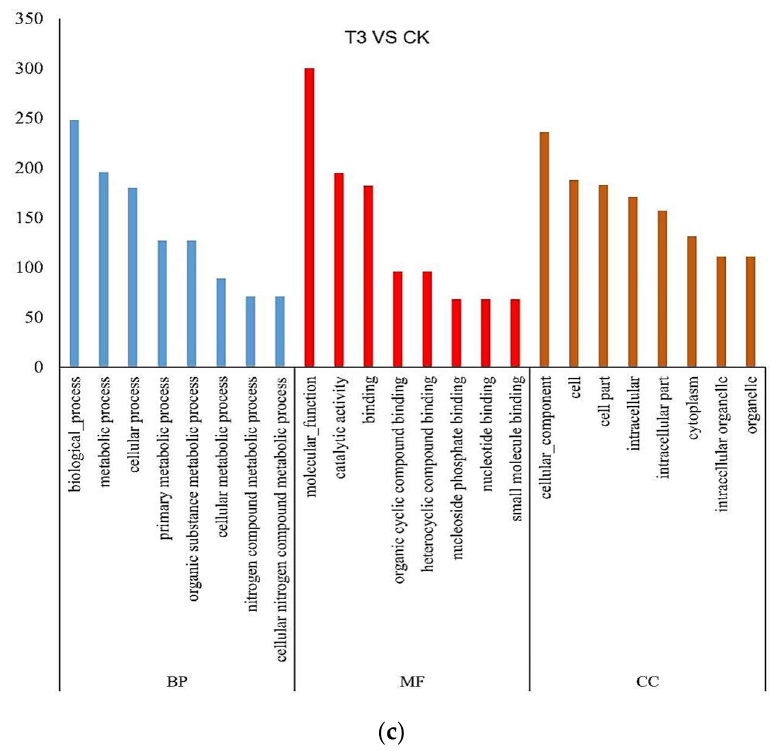
Figure 2. Gene ontology annotation. ( a ): CK treatment at 12 hpi; ( b ): CK treatment at 24 hpi; ( c ): CK treatment at 48 hpi. BP: biological process; MF: molecular function; CC: cellular component.